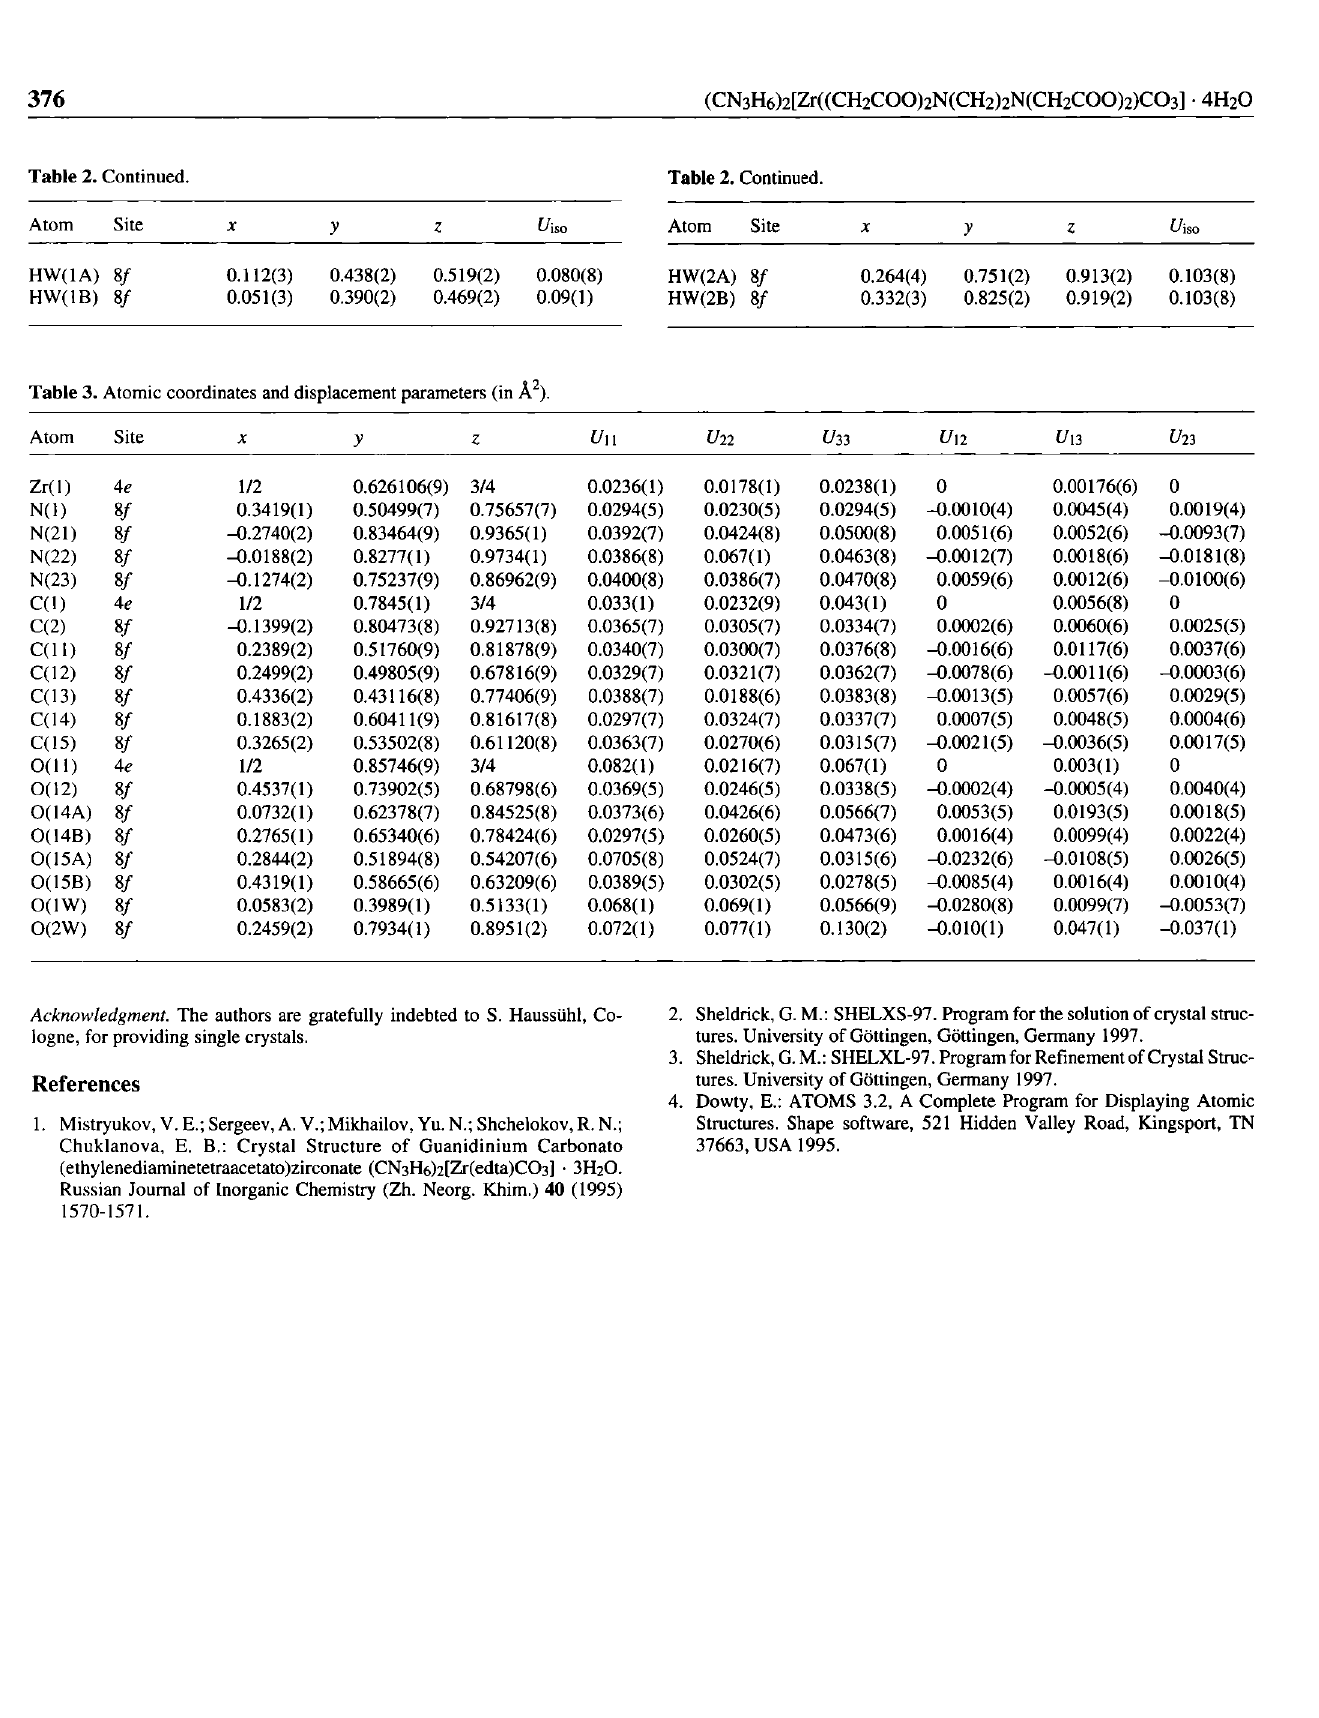
Table 3. Atomic coordinates and displacement parameters (in Ä 2